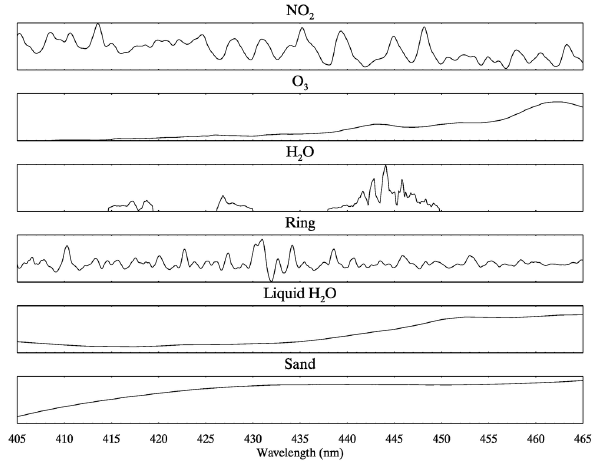
Figure 1. The absorption cross-sections used in this work (see Ta- ble 1). Figure 2. Atmospheric volume mixing ratio (VMR) profiles used in